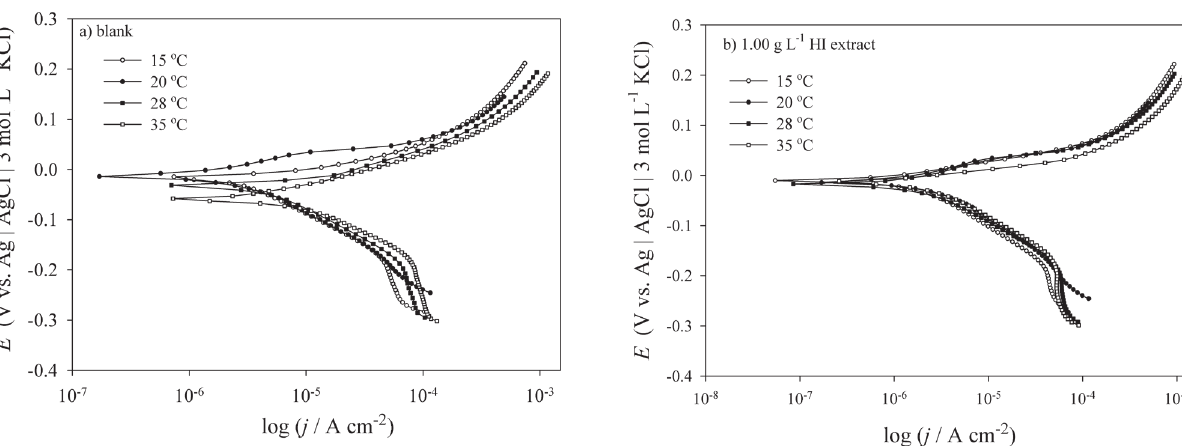
Fig. 4 – Effect of temperature on polarization curves of Cu corrosion rate in simulated acid rain solution a) without, and b) with 1.00 g L –1 HI extract Table 5 – Electrochemical parameters (polarization mea­ surements) and calculated values of surface coverage, q , and inhibition efficiency, h , obtained from data shown in Fig. 4